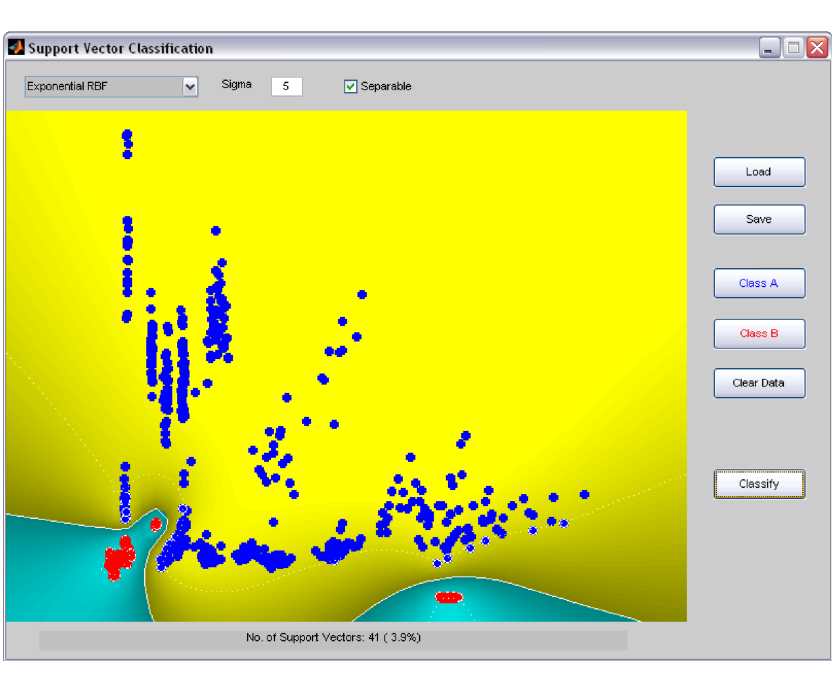
Figure 3. RMS–kurtosis map with the projection of the hyperplane that divides healthy (red dots) and faulty (blue dots) training datasets. Toolbox developed by Prof. S.R. Gunn, University of